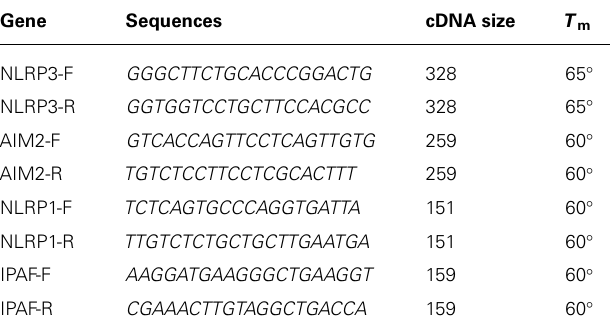
Table 1 | Gene primer